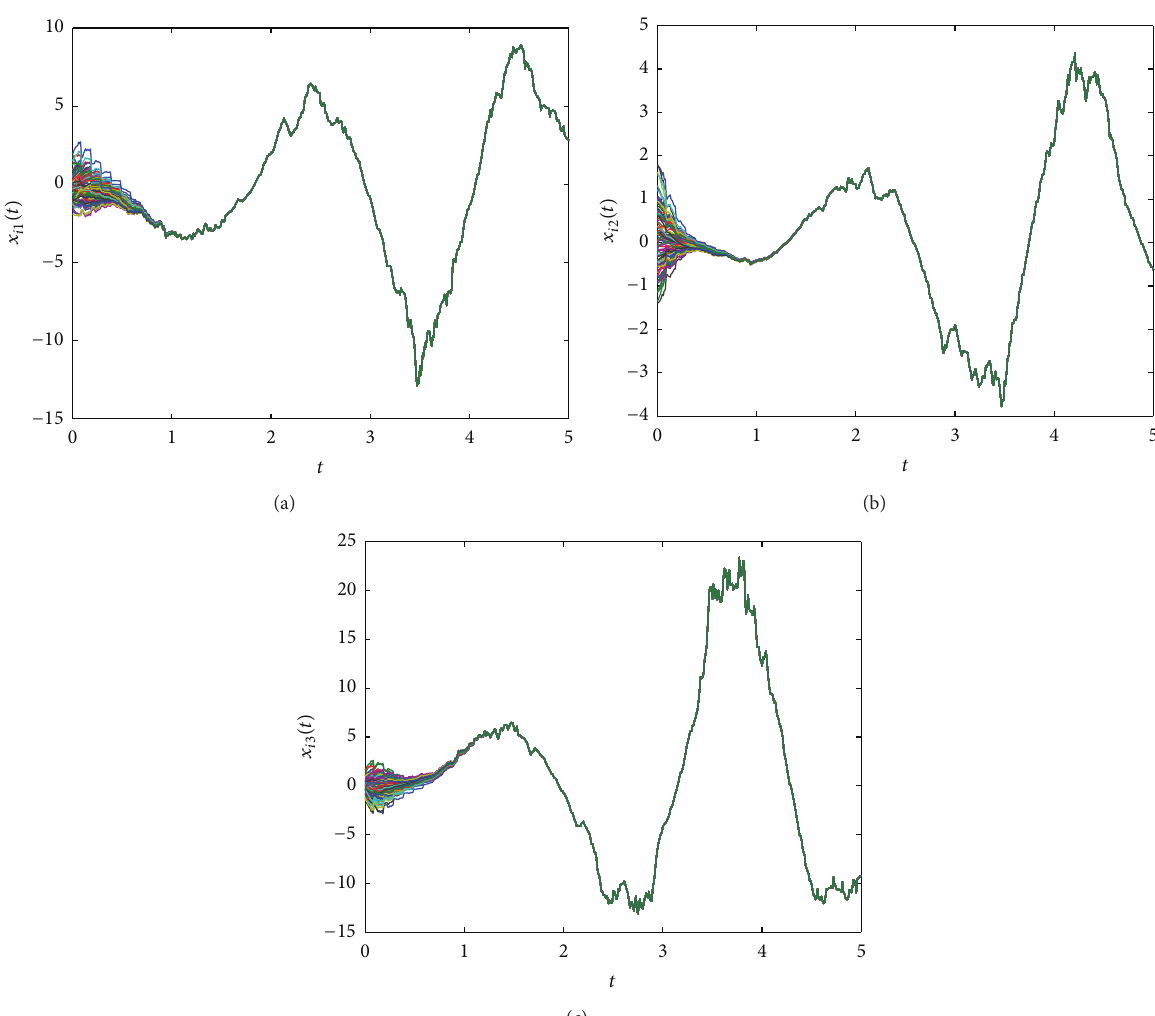
Figure 4: State variables 𝑥 𝑖 (𝑡), 𝑖 = 1, 2, .. ., 100 of the coupled dynamical network with impulsive disturbances when |𝜇| > 1 .